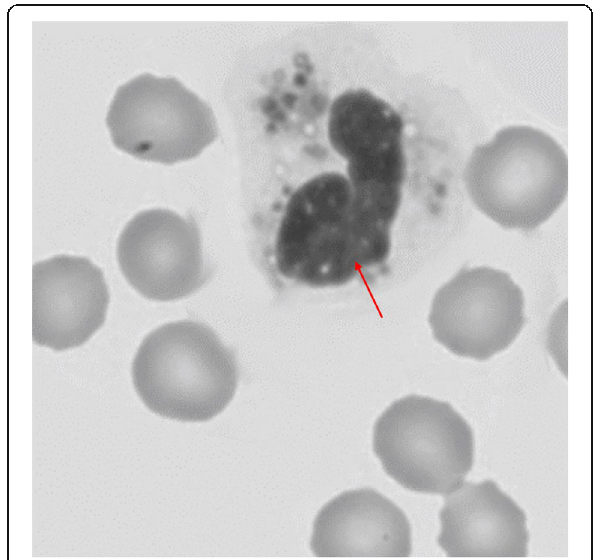
Fig. 1 Bone marrow examination for patient with CHS. Giant intracytoplasmic inclusion in leukocyte is indicated by red